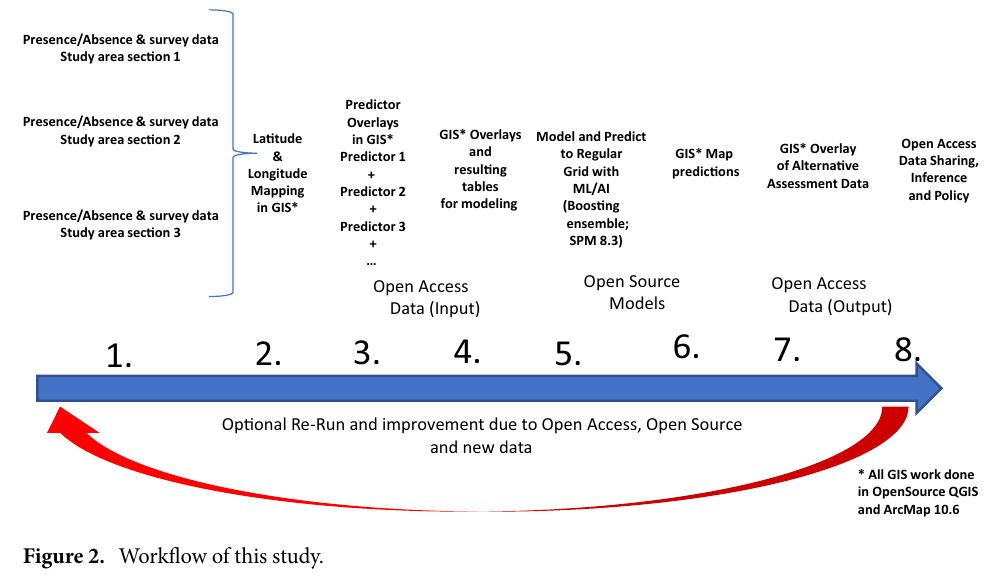
Figure 2. Workflow of this